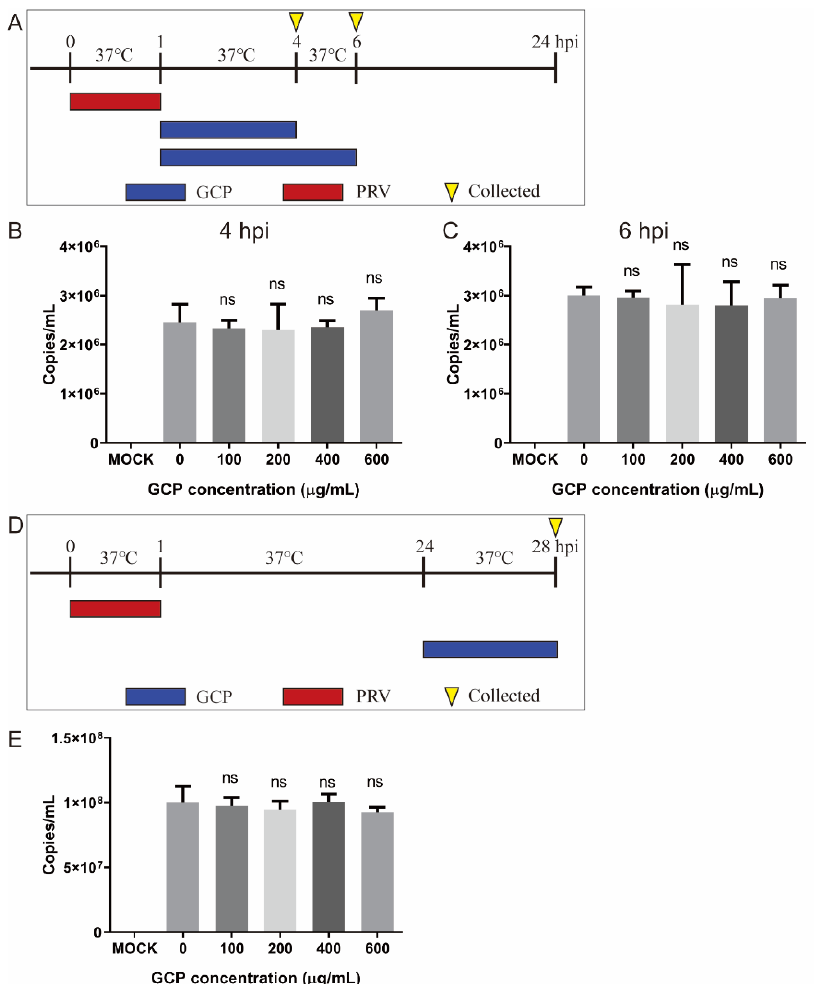
Figure 7. GCP had no effect on PRV replication and release. ( A – C ) PK-15 cells were infected with PRV XJ5 (MOI = 0.1) at 37 °C for 1 h, then incubated with GCP at 37 °C. At 4 and 6 hpi, the copy numbers of PRV DNA were quantified by qRT-PCR. ( D , E ) PK-15 cells were infected with PRV XJ5 (MOI = 0.1) for 24 h, washed, and incubated with fresh DMEM containing GCP for another 4 h, The copy numbers of PRV DNA in supernatants were quantified by qRT-PCR. All results were obtained from three independent experiments and were presented in means ± SD (ns, not significant).